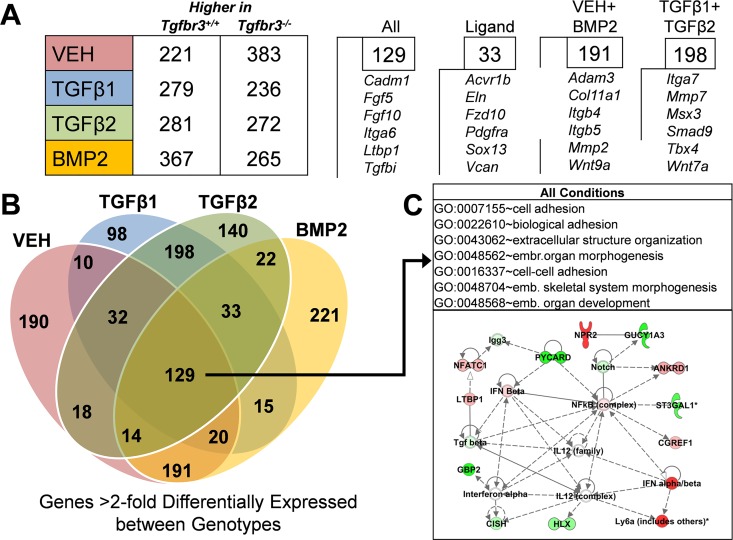
RNA-seq analysis identifies genes dysregulated in Tgfbr3-/- epicardial cells.(A) (Left) The number of genes >2-fold (p<0.001) differentially expressed between Tgfbr3+/+ and Tgfbr3-/- epicardial cells for each group. (Right) The number genes similarly dysregulated within selected groups that were also annotated in the IPA database are shown with genes found in each. (B) The number of overlapping genes >2-fold differentially regulated (p<0.001) was determined and mapped. 129 genes were similarly dysregulated across all groups. (C) (Top) Gene ontology analysis of these 129 genes by DAVID revealed a significant (p<0.0001) enrichment of genes associated with specific biological processes. emb.- embryonic. (Bottom) A representative network generated by gene regulatory network analysis of the 129 genes using Ingenuity Pathway Analysis software is depicted. Green- expressed higher inTgfbr3+/+, Red- expressed higher in Tgfbr3-/-.